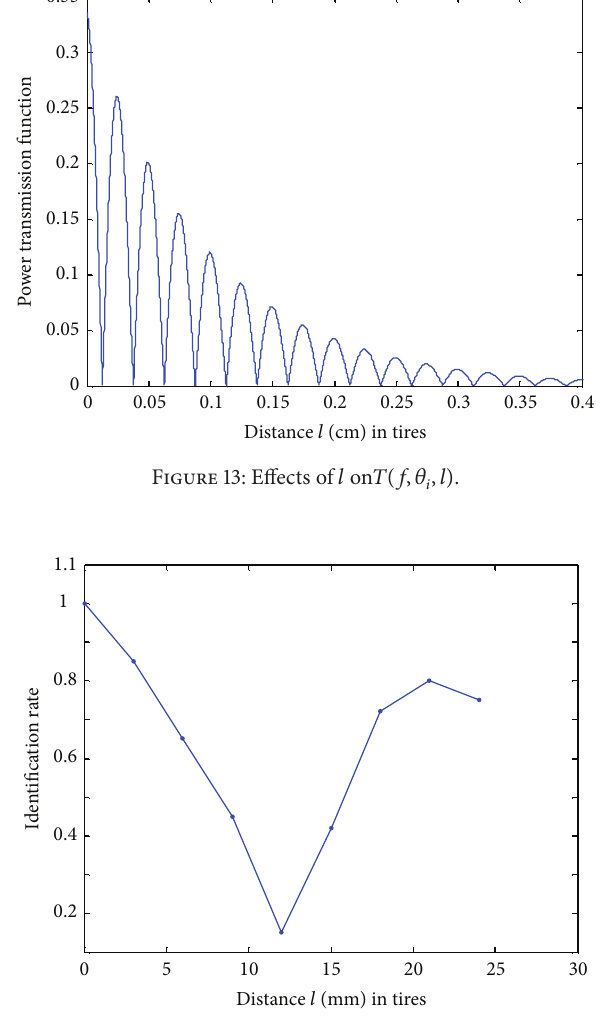
Figure 14: Relations 𝑙 and identification rate.